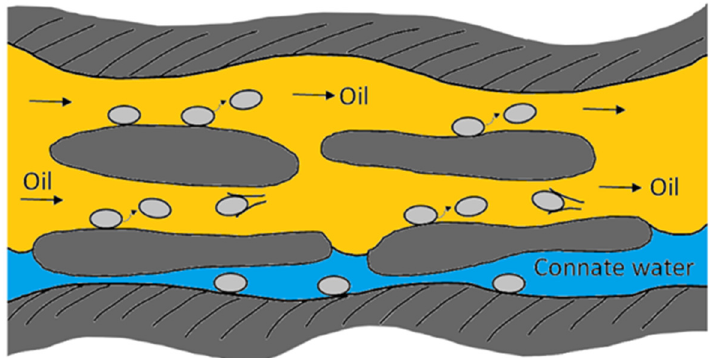
Figure 1. Schematic for permeability damage during lifting, migration, and straining of fines in porous space.